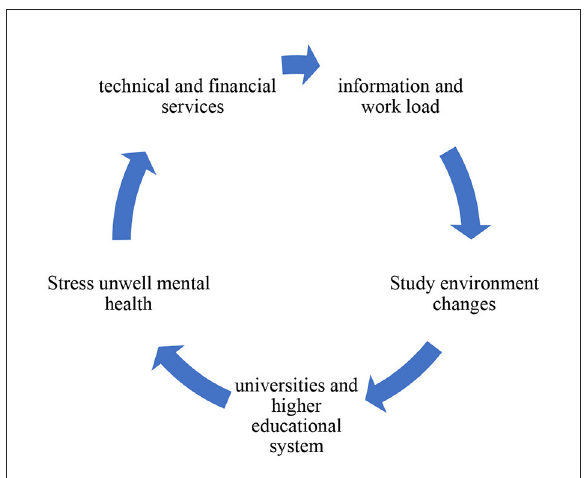
FIGURE2 Summary of challenges due to the COVID-19 pandemic on university